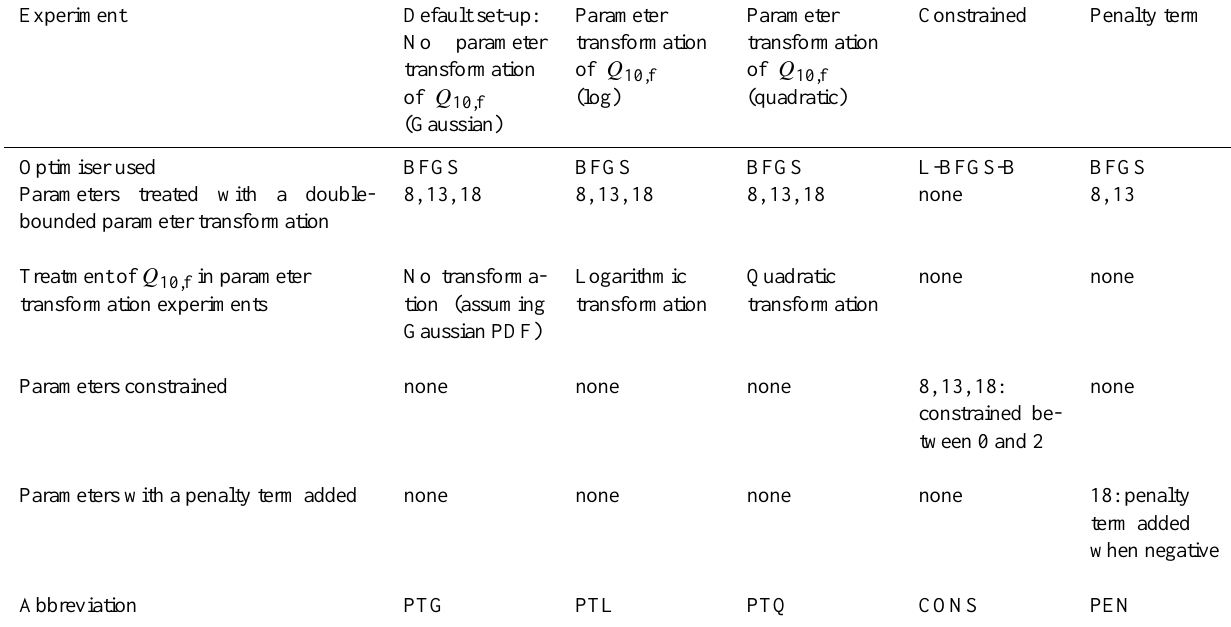
Constrained Penalty term Parameter Parameter transformation transformation No parameter of Q 10,f of Q 10,f transformation (quadratic) (log) of Q 10,f (Gaussian)